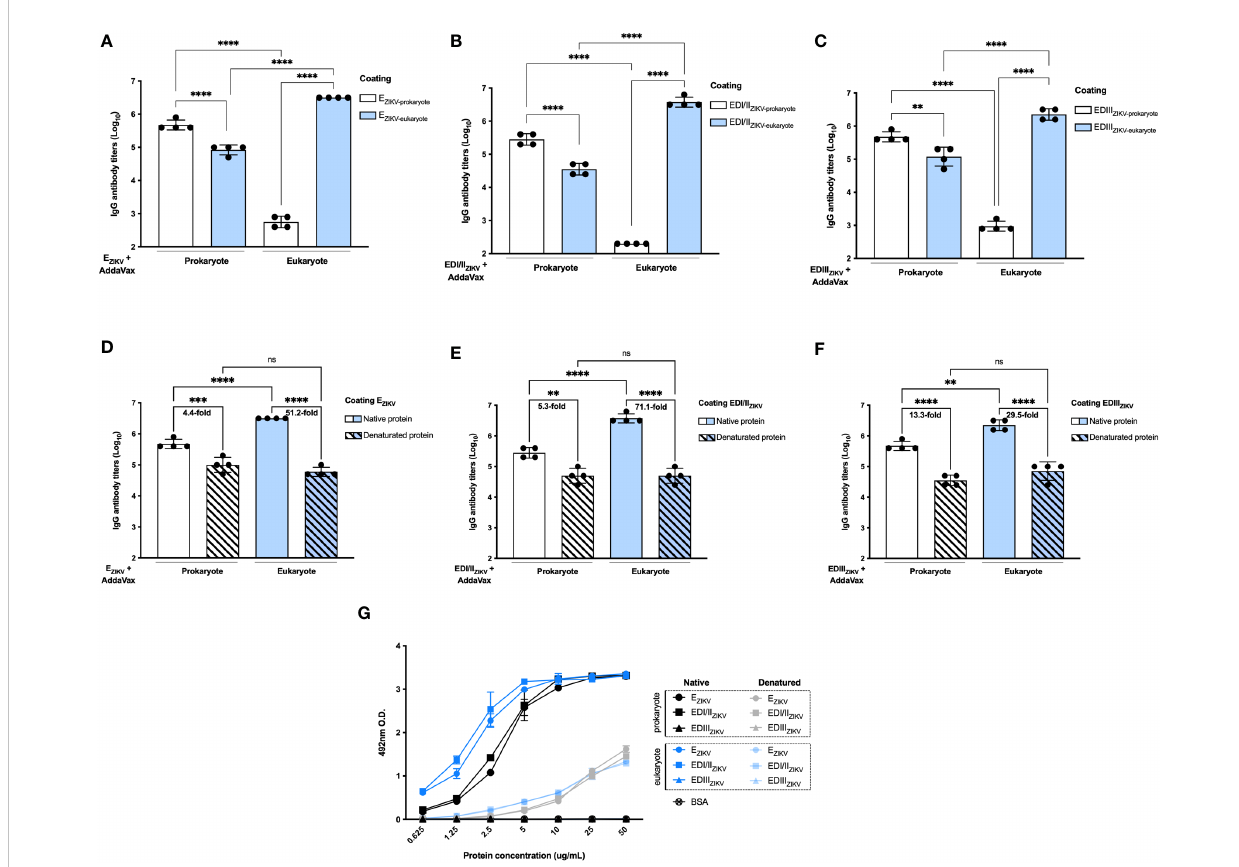
FIGURE 4 Antigenicity and conformational epitopes of recombinant ZIKV antigens produced in bacterial or insect cells. Binding of serum antibodies from mice immunized with (A) E ZIKV , (B) EDI/II ZIKV and (C) EDIII ZIKV expressed in bacteria or insect cells (immunization strategy presented in Figure 2A) to recombinant antigens produced in each system. Binding of serum antibodies from mice immunized with (D) E ZIKV , (E) EDI/II ZIKV and (F) EDIII ZIKV proteins expressed in bacteria or insect cells (immunization strategy presented in Figure 2A) to recombinant antigens produced in each system and submitted or not to denaturation by heat. Numbers on top of bars represent the reduction (in fold change) of the reactivity between intact and denatured proteins in each group. (G) Binding of the anti- fl avivirus 4G2 monoclonal antibody that recognizes a conformational epitope on the E protein structure. Statistical signi fi cance was measured by One-way ANOVA followed by Tukey ’ s post hoc test, **p < 0.01, *** p < 0.001, ****p < 0.0001, ns,not signi fi cant. Data represent mean ± SD and are representative of 3 independent